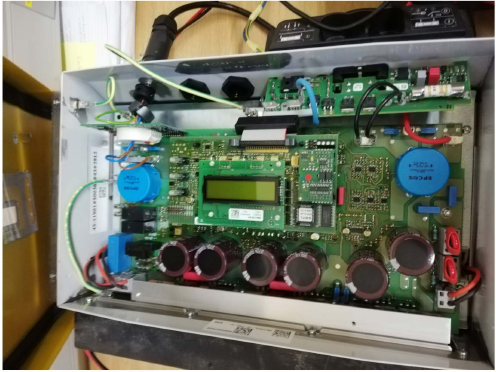
Figure 14. The inverter under investigation.